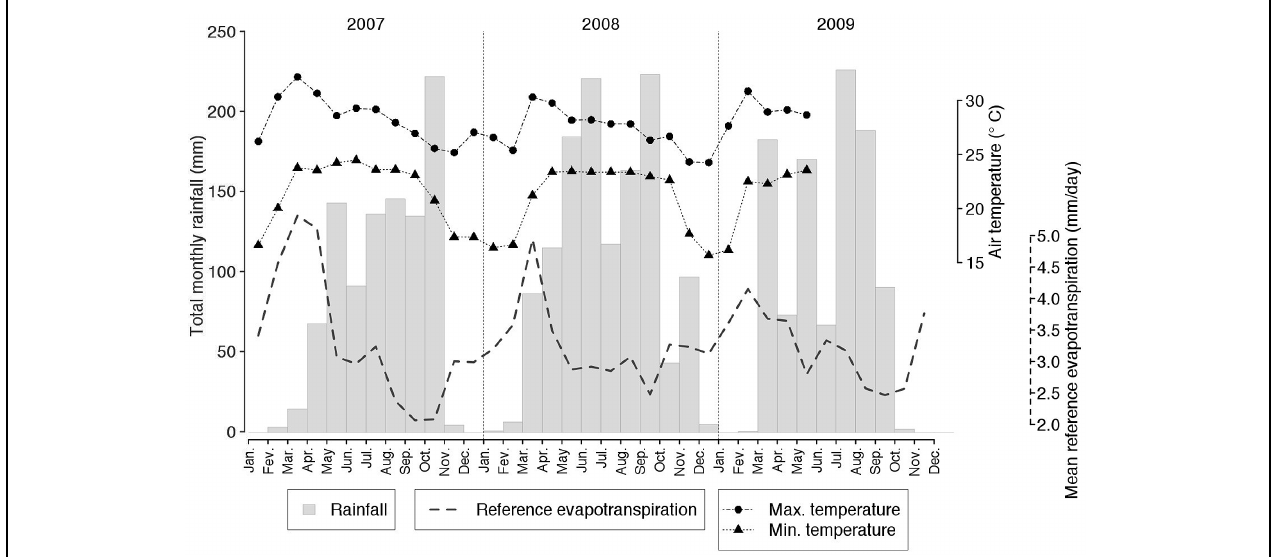
FIGURE 1 | Monthly rainfall, minimum and maximum air temperatures and reference evapotranspiration monitored at the experimental site from January 2007 to December